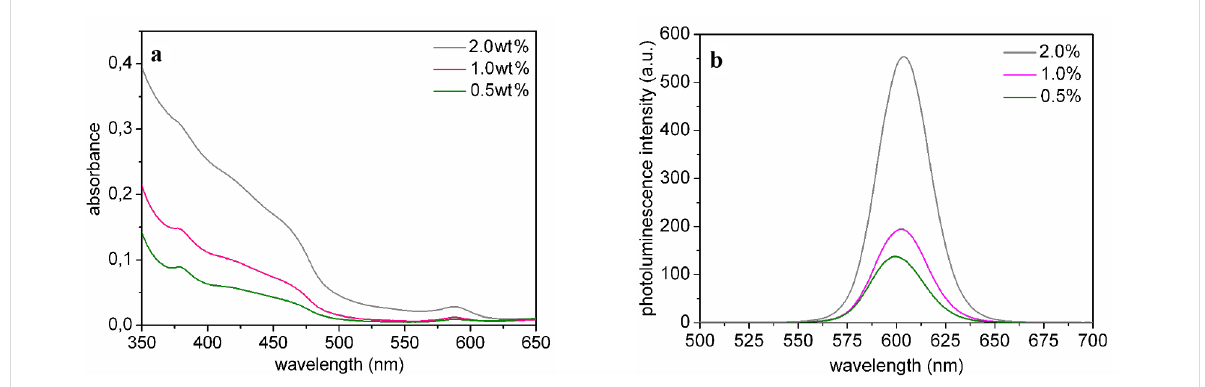
Figure 10: a) Absorption spectra and b) PL spectra of CTA nanocomposites containing NRs (aspect ratio 6) for different NR concentrations.